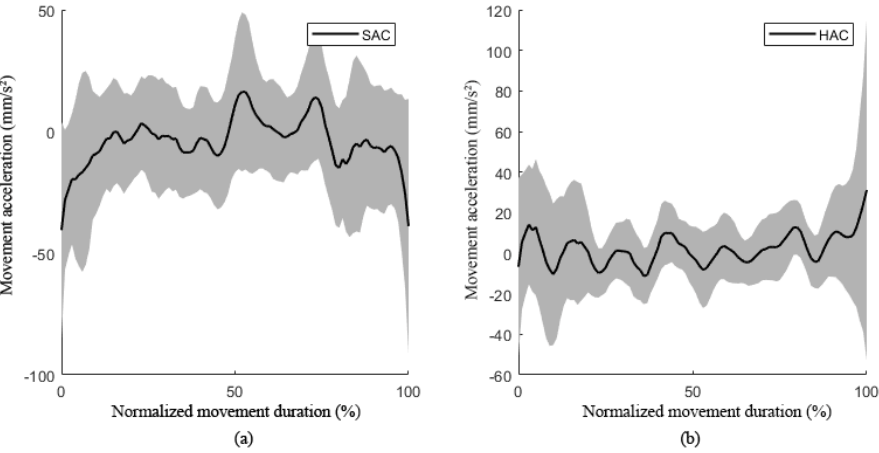
Figure 10. Movement acceleration during movement: ( a ) movement acceleration during movement of stroke patients; ( b ) movement acceleration during movement of healthy subjects.